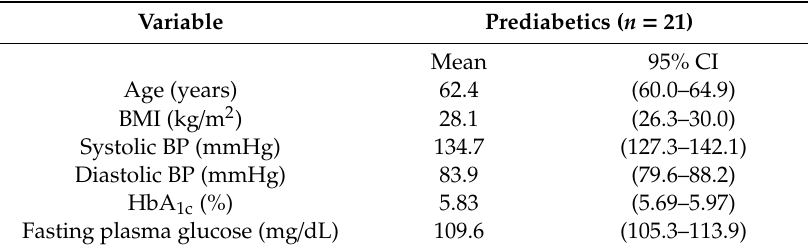
Table 1. Demographic and screening